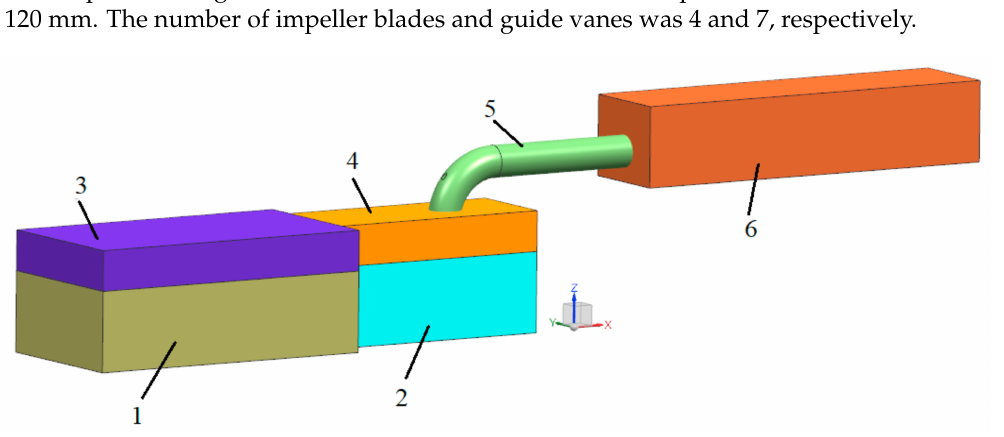
Figure 2. Three-dimensional geometric model. 1, forebay; 2, pump sump; 3, air; 4, air; 5, outlet pipe; and 6, outlet tank.